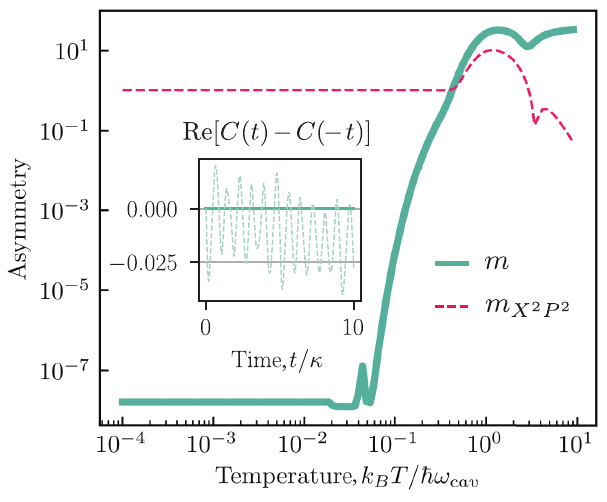
FIG. 8. Hidden-TRS breaking in a driven nonlinear cavity. Main plot: total correlation-function time asymmetry m ( T ) ver- sus temperature for a parametrically driven Kerr resonator, cf. Eq. (81). Solid green: integrated asymmetry for the special ( t ) [cf. Eq. (80)], which is guaranteed correlation function C a 2 , H eff to be symmetric if hidden TRS holds. There is a sudden onset of asymmetry above a threshold temperature, indicating a sharp temperature at which hidden TRS is broken. In contrast, we also plot the total time asymmetry of a correlation function whose ( t ) behavior is not constrained by hidden TRS, function C X 2 , P 2 (dashed red curve); here ˆ X and ˆ P are standard quadrature opera- tors. This correlator is asymmetric already at zero temperature, and shows no strong temperature dependence. Inset: real part ( t ) for of the correlation-function asymmetry of C ( t ) ≡ C a 2 , H eff = 0 (solid green), and ¯ n = 0.2 (dashed green). For all plots ¯ n th th we take (cid:15) 2 = 3 K , κ 1 = 0.01 K , (cid:9) = (cid:15) 1 = κ 2 = 0.